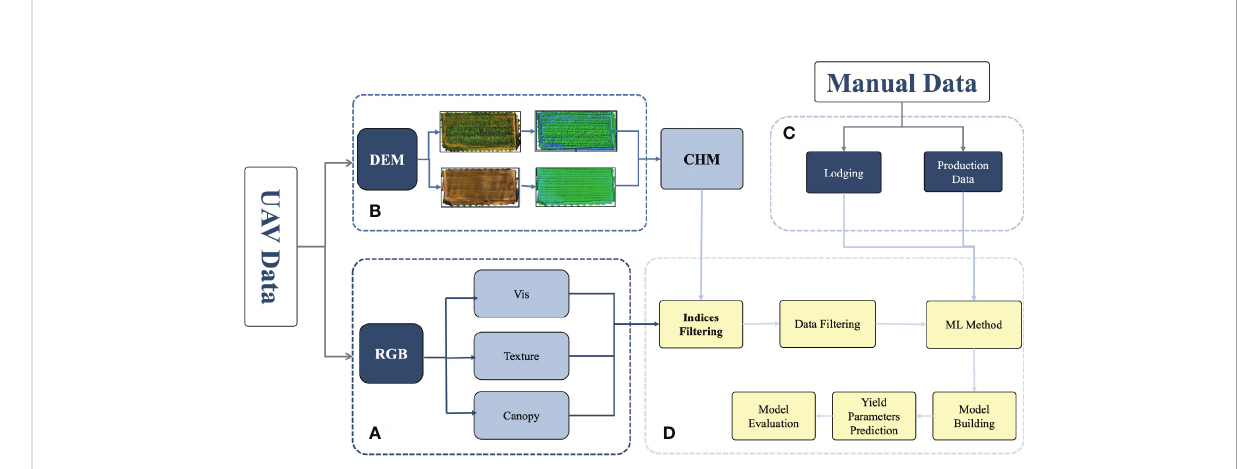
FIGURE 2 Flowchart for estimating the yield parameters. (A) RGB indices extraction process. (B) Calculation of the plant height using DEM. (C) Manual data, including lodging and yield parameters, such as the grain number of seeds per plant and grain weight per plant. (D) Data cleaning and model building. DEM, digital elevation model; RGB, red green